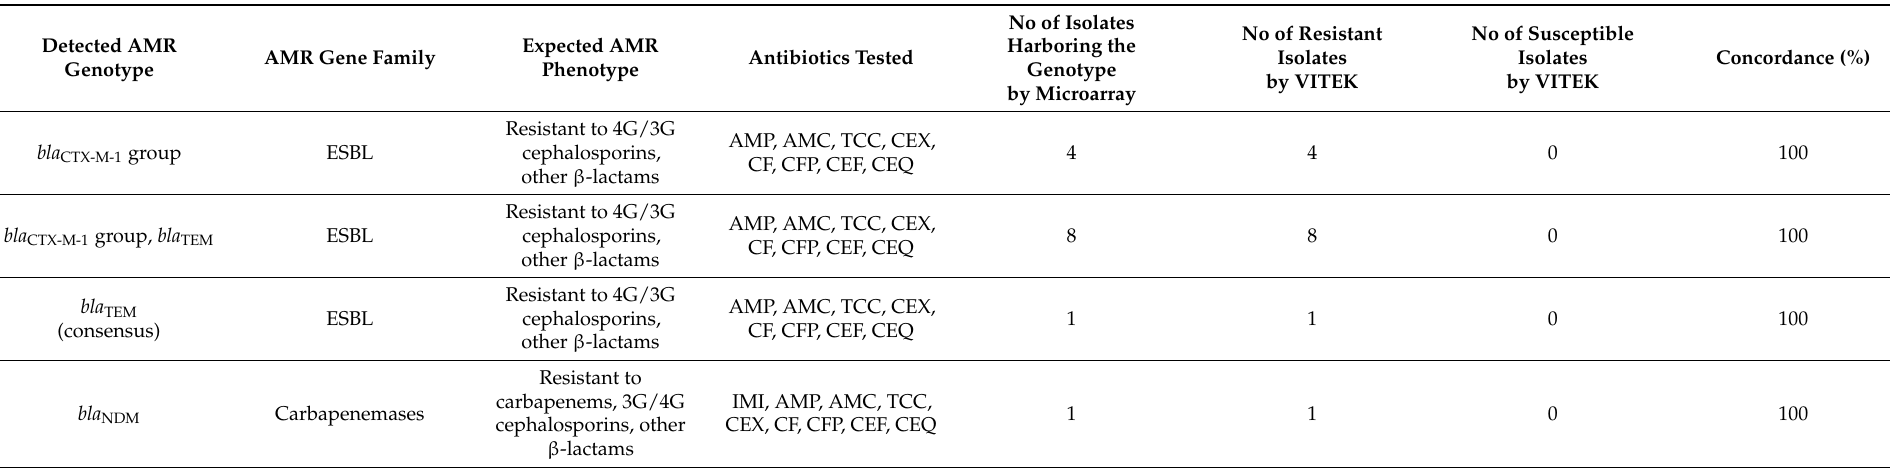
Table 3. Comparison between the microarray-based genotype and the phenotype obtained by VITEK-2